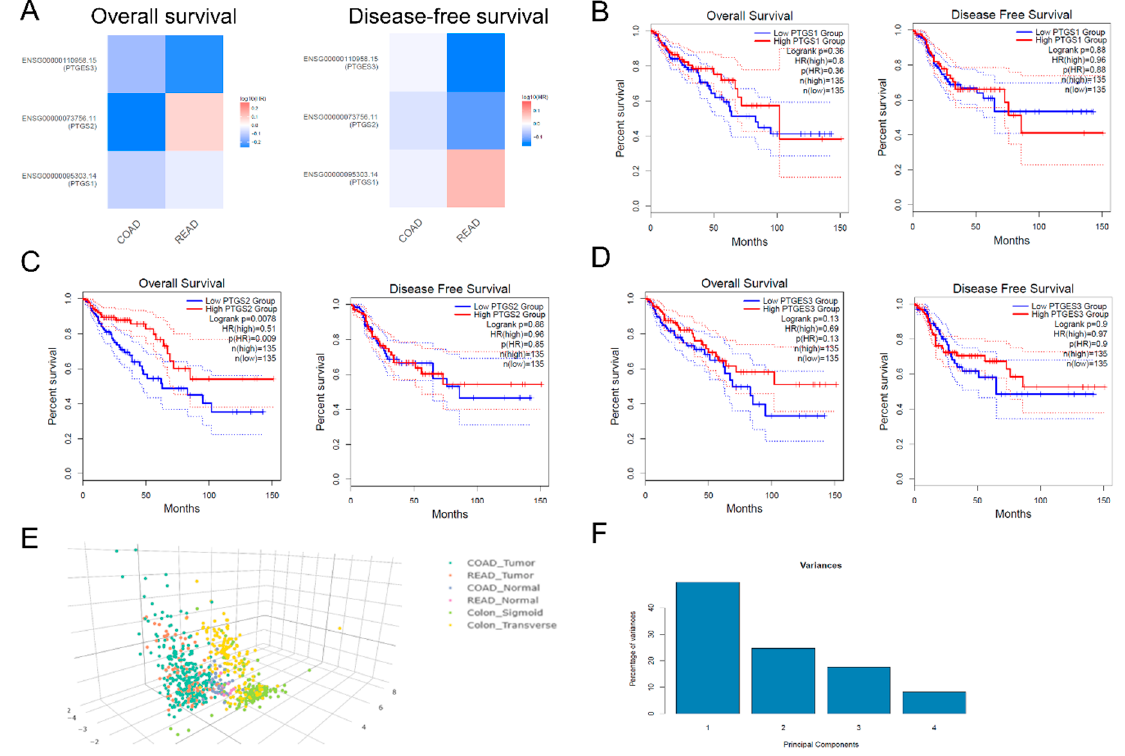
Figure 4. ( A – D ) PTGS1 and PTGES3 expression are is unrelated to CRC patient survival; however, PTGS2 expression is significantly associated with a better overall (but not disease-free) survival among CRC patients ( p = 0.0078, log-rank test). ( E , F ) Colorectal tumors (COAD and READ) clustered separately from the corresponding normal tissues, as well as from the sigmoid and transverse normal colon